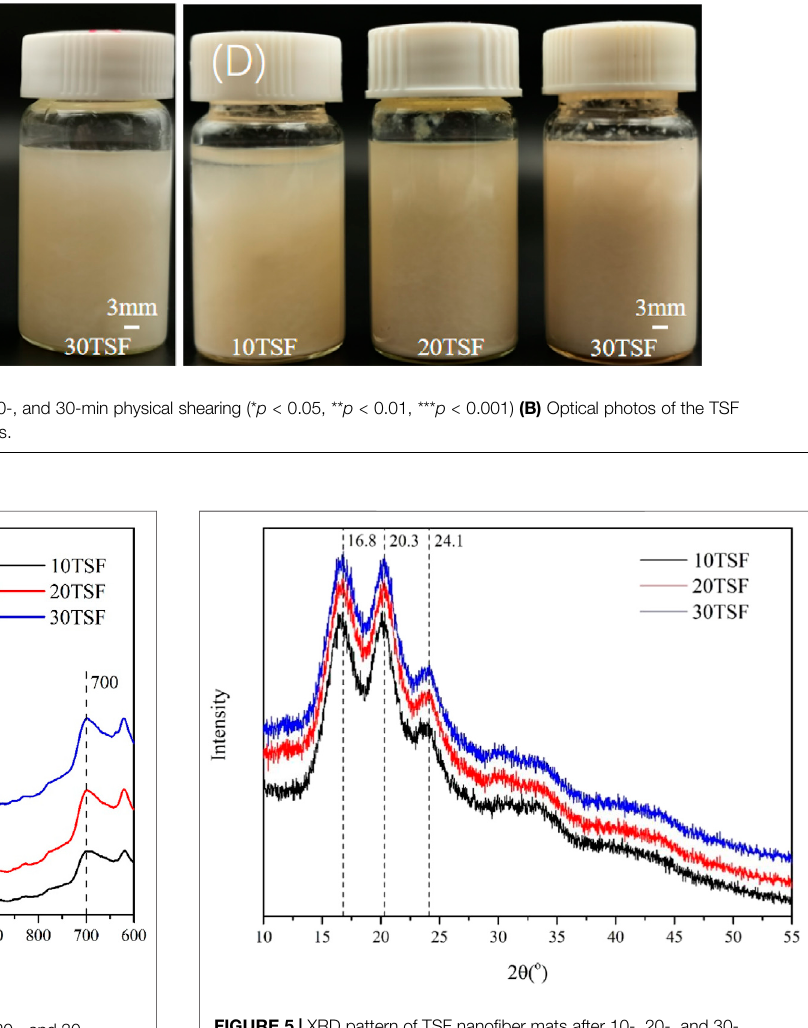
-sheet structure, con fi rming the similar result to the FTIR